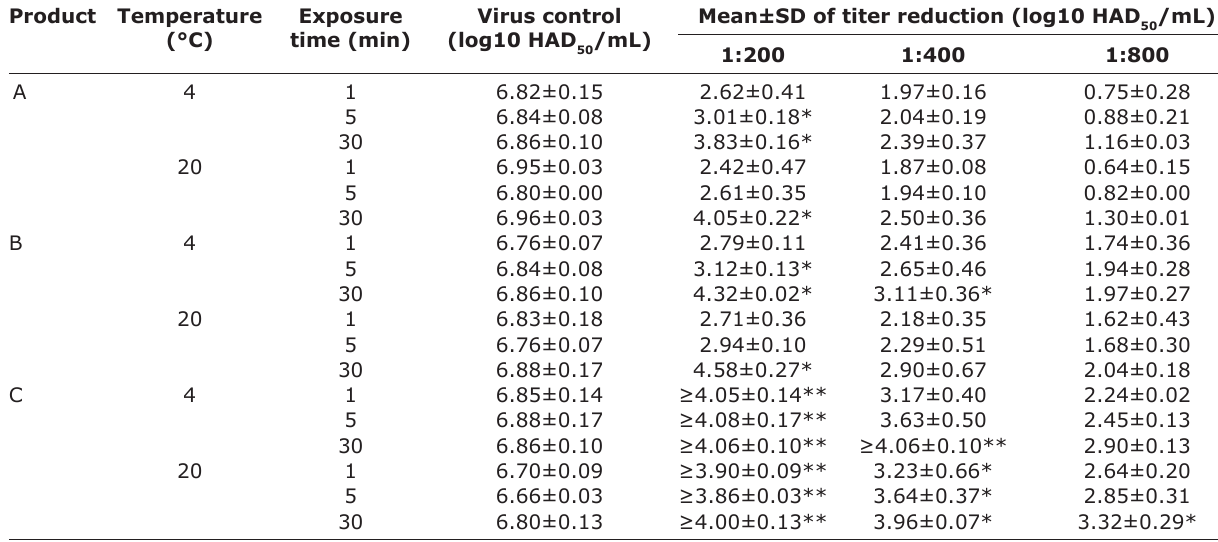
Cutoff of cells viability was indicated when live cells clung to the bottom of tissue culture microplate more than 80% of the 5-day culturing period. PAM=Porcine alveolar macrophage Table-2: Virucidal efficacy of two potassium hydrogen peroxymonosulfate disinfectants and a quaternary ammonium compound disinfectant against African swine fever virus under various concentrations, exposure times, and